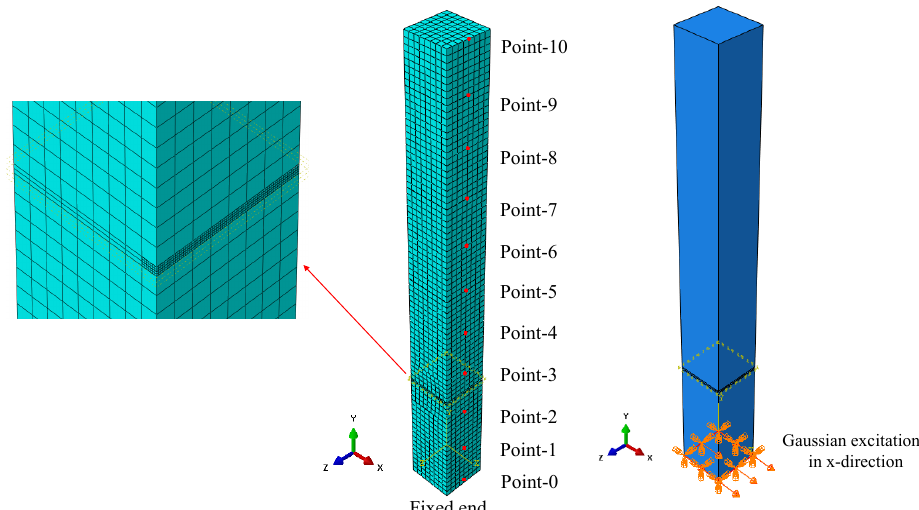
Figure 2. Schematic representation of a cantilever FE beam model with a horizontal breathing crack.